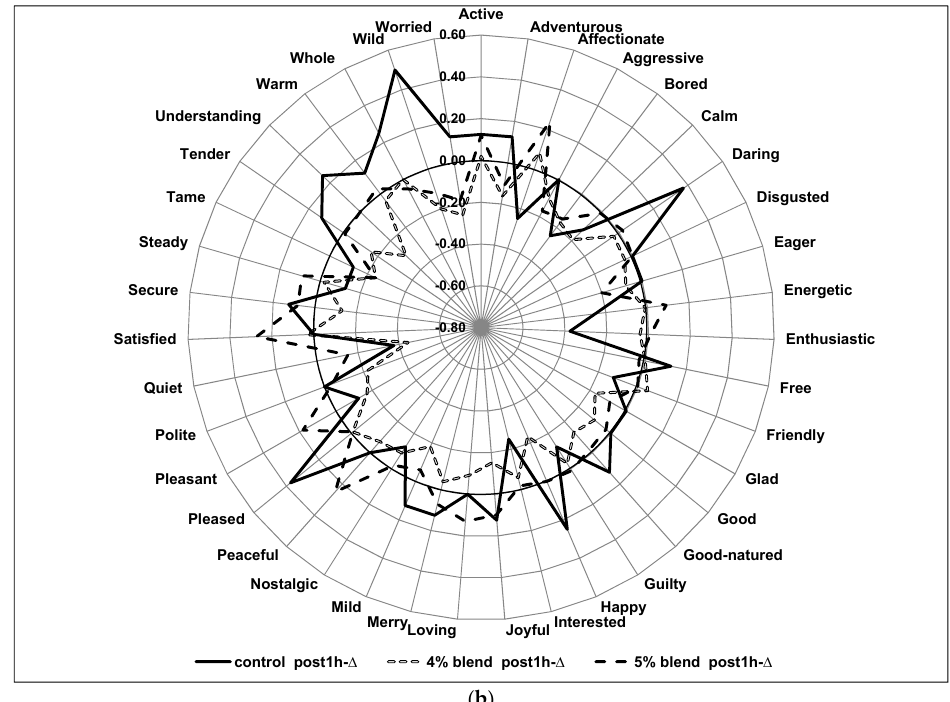
Figure 3. ( a ) Emotion intensity changes over time for all the products: Post0 ‐∆ scores. ( b ) Emotion intensity changes over time for all the products: Post1h ‐∆ scores. Legend—Post0 ‐∆ = immediate ‐ post consumption—pre consumption; Post1h ‐∆ = one ‐ hour post consumption—pre consumption.